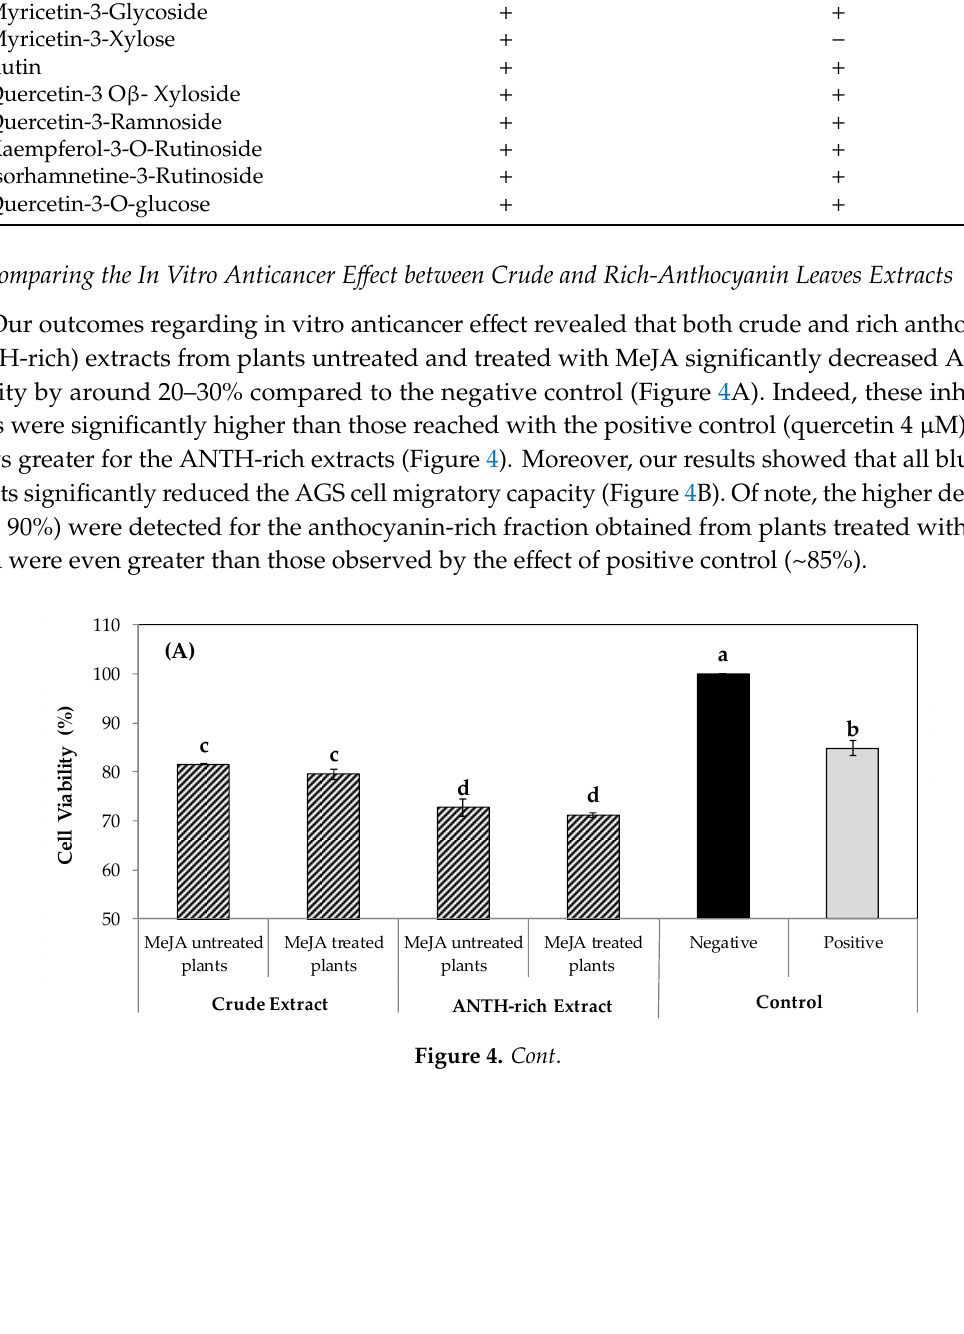
Figure 4. Effect of crude and anthocyanin-rich (ANTH-rich) extracts of leaves from plants untreated and treated with MeJA on cell viability ( A ) and cell migration ( B ) of the AGS gastric cancer cell line. Cell viability was measured after 24 h of extract incubation using AlamarBlue reagent and determining the fluorescence intensity at 530/560 nm. The percentage of viable cells relative to the control cells was calculated. To assess the migratory capacity, cells were exposed to increasing concentrations of leaf extracts during 1 h. The number of cells migrating in the presence of serum-free medium and buffer DPBS represented 100% of cell migration (control), whereas the values of cell migration after the extract exposure were calculated in relation to the control. All extracts were evaluated at a final concentration of 100 µg mL − 1 . Distilled water was used as a negative control, whereas a quercetin aqueous solution (4 µM) was used as a positive control. Lower case letters (a–d) indicate significant differences among the treatments according to the Tukey test ( p ≤ 0.05). Error bars represent the standard error of the data set. ( C ) Representative images of the effect of each treatment on AGS cell migration under a light microscope and 20× objective. 3.4. Evaluation of Rich Anthocyanin Extracts of Leaves from MeJA-Treated Plants Over In Vivo Models